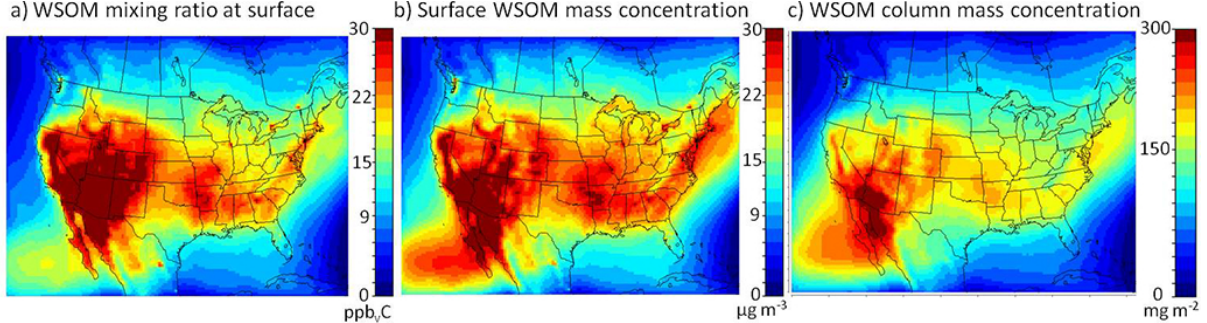
Fig. 1. (a) Sum of gas-phase CMAQ water-soluble organic gases shown in lab experiments to make SOA AQ : glyoxal (Carlton et al., 2007), methylglyoxal (Tan et al., 2010), acetaldehyde (Li et al., 2011), phenols (Sun et al., 2010), acetone (Poulain et al., 2010), acetic acid (Tan et al., 2012), methacrolein (El Haddad et al., 2009) and glycolaldehyde (Perri et al., 2010). Note that glycolaldehyde is not an explicit species in SAPRC99 (used in this simulation) and is counted as half of model species “RCHO”. For the mixing ratio (a) , all gases are presented in ppb V -carbon. The mass concentrations in (b) and (c) are converted from the molar ratios using the ideal gas law. Values are July 2003